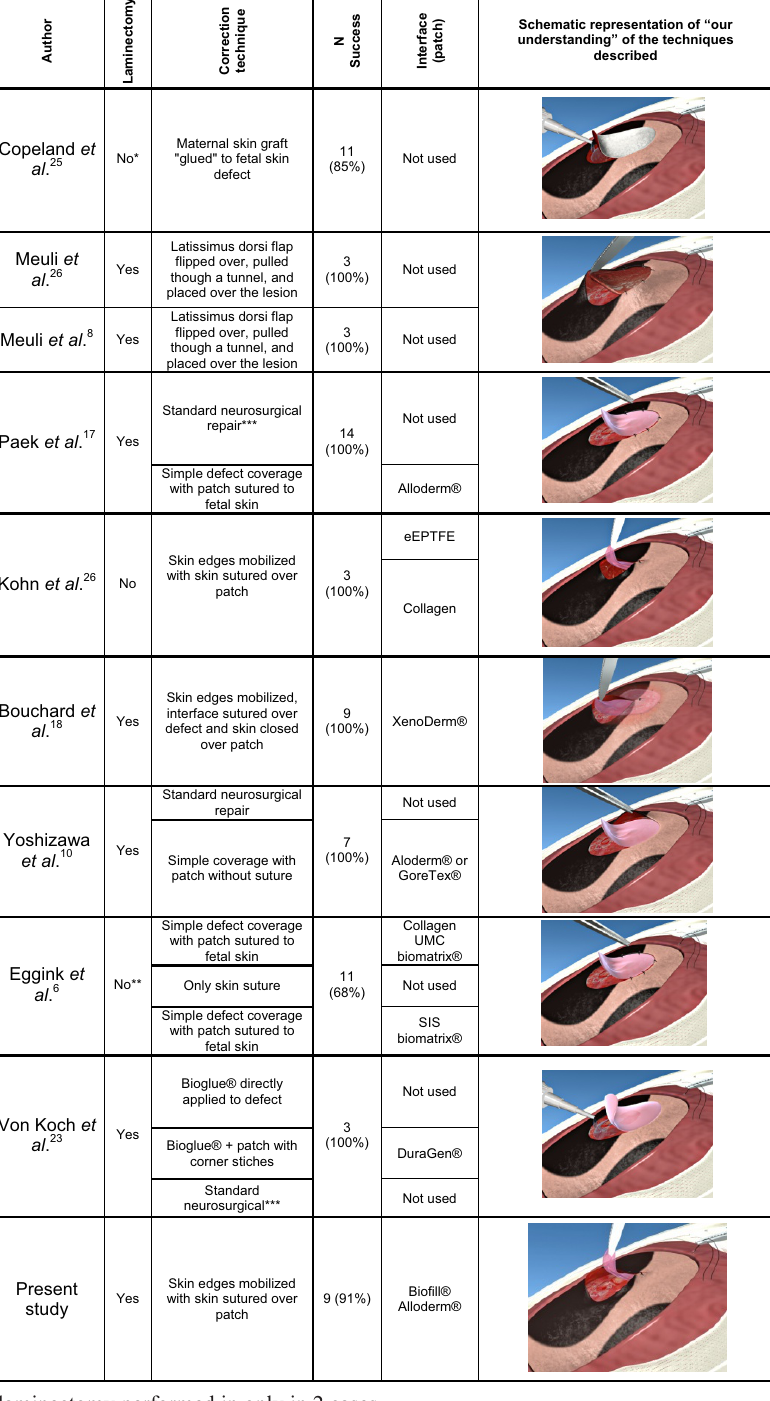
*laminectomy performed in only in 2 cases **laminectomy not performed in 4cases ***Standard neurosurgical repair: neural placode reformed into a tube, paraspinal muscles partially re -approximated and skin